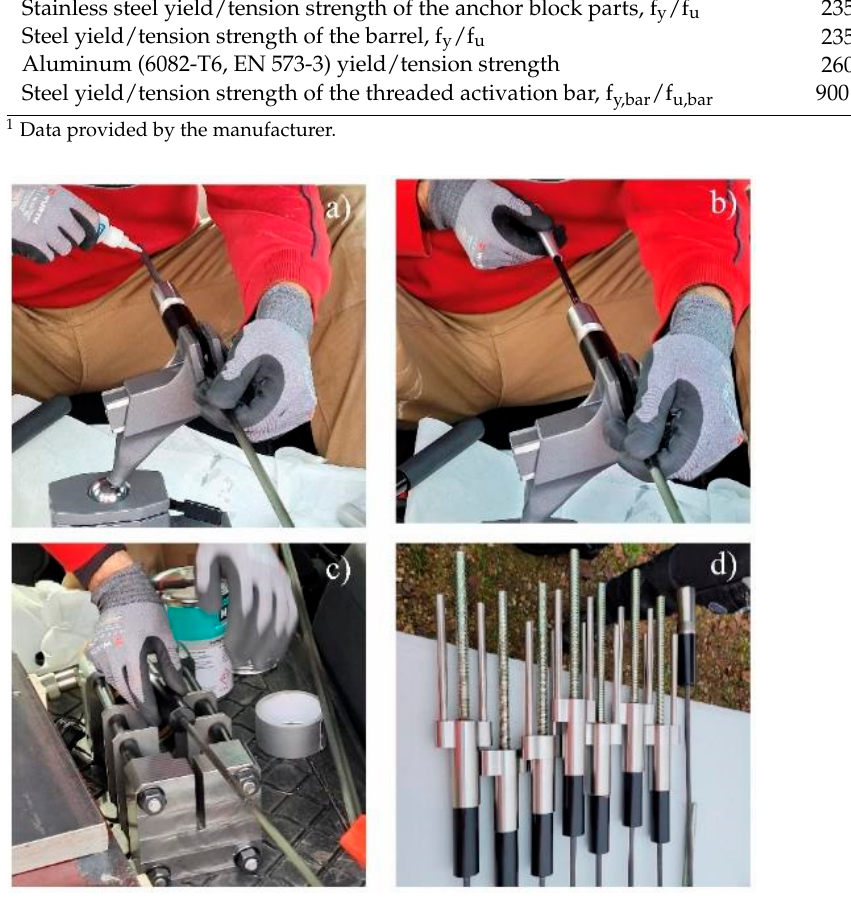
could potentially cause premature failure of the CFRP rod. The pins are screwed into the coupler “ears” and can slide into the anchor block. Consequently, an undisturbed direct tension of the CFRP rod was deemed possible when pre-stressing was applied through the nut at the back of the anchor